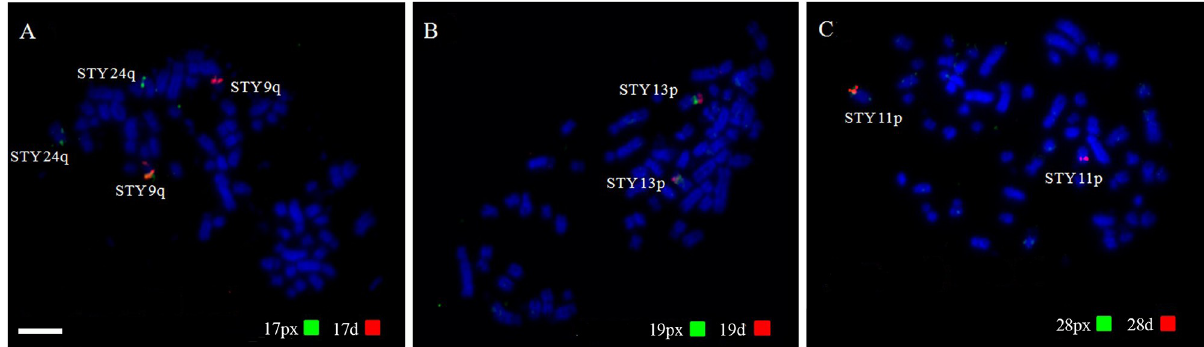
Fig 3. Representative results of hybridizations with some G . gallus BACs probes in the karyotype of S . tyrannus . (A1 and A1.1) chicken BAC17 was the only one to hybridize to different chromosomes. Red signals represent probes labeled with Cy3, corresponding to the proximal region (px); Green signals represent probes labeled with FITC, corresponding to the distal region (d). Arrows indicate the signals. Scale bar: 5 μ m.